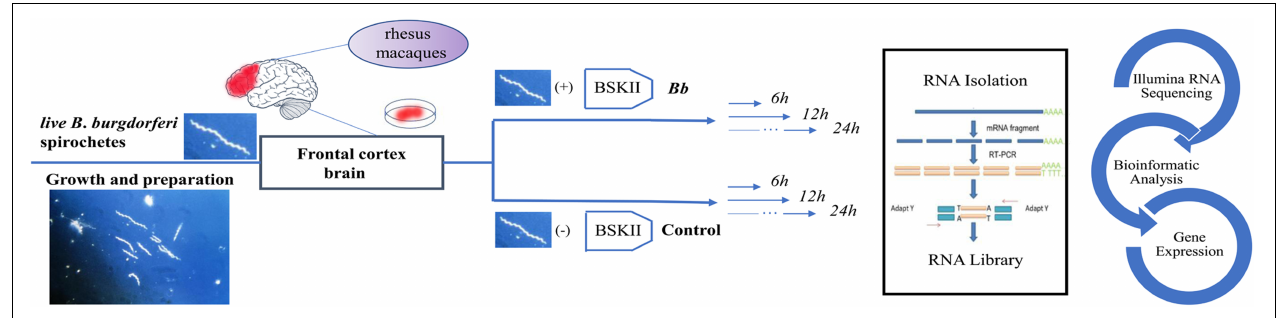
FIGURE 1 | Schematic description of the experimental design. The asterisk represents the Borrelia burgdorferi